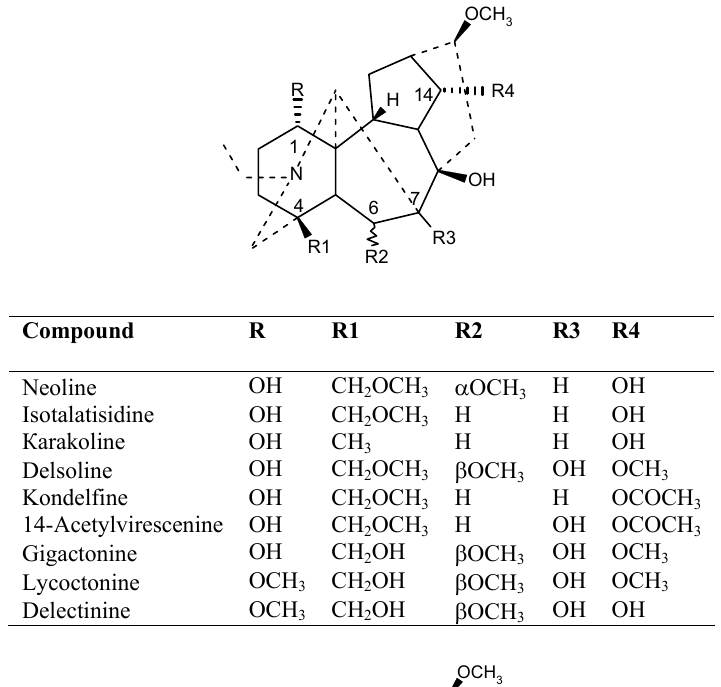
Figure 1. Diterpene alkaloids with variations at C-1, C-4, C-6, C-7 and C-14 of lycoctonine